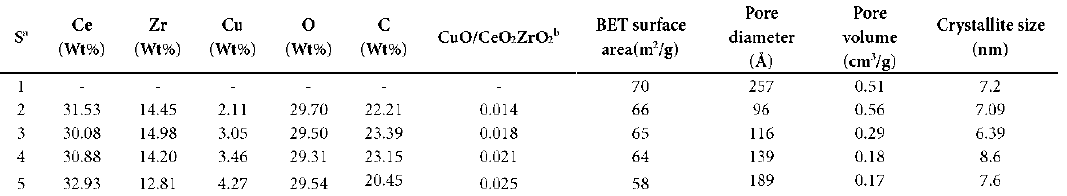
ZrO heterojunction photocatalyst prepared with 2 4